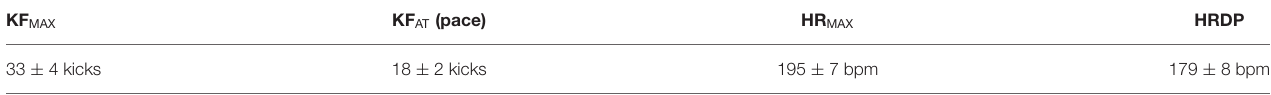
TABLE 2 | Mean and standard deviation of the variables obtained during the pace training at an intensity corresponding to the intensity of the heart rate deflection point (HRDP) ( n = 12). HRDP (CI) HR ROUND1 (CI) HR ROUND2 (CI) HR ROUND3 (CI) 179 ± 8 bpm (174 – 185) 167 ± 10 bpm a (160 – 173) 178 ± 11 bpm b (171 – 184) 179 ± 10 bpm b (173 – 186) HR, heart rate; internal load value for rounds 1, 2, and 3 in comparison with the HRDP obtained for the pace identified during the PSTT. a Different to